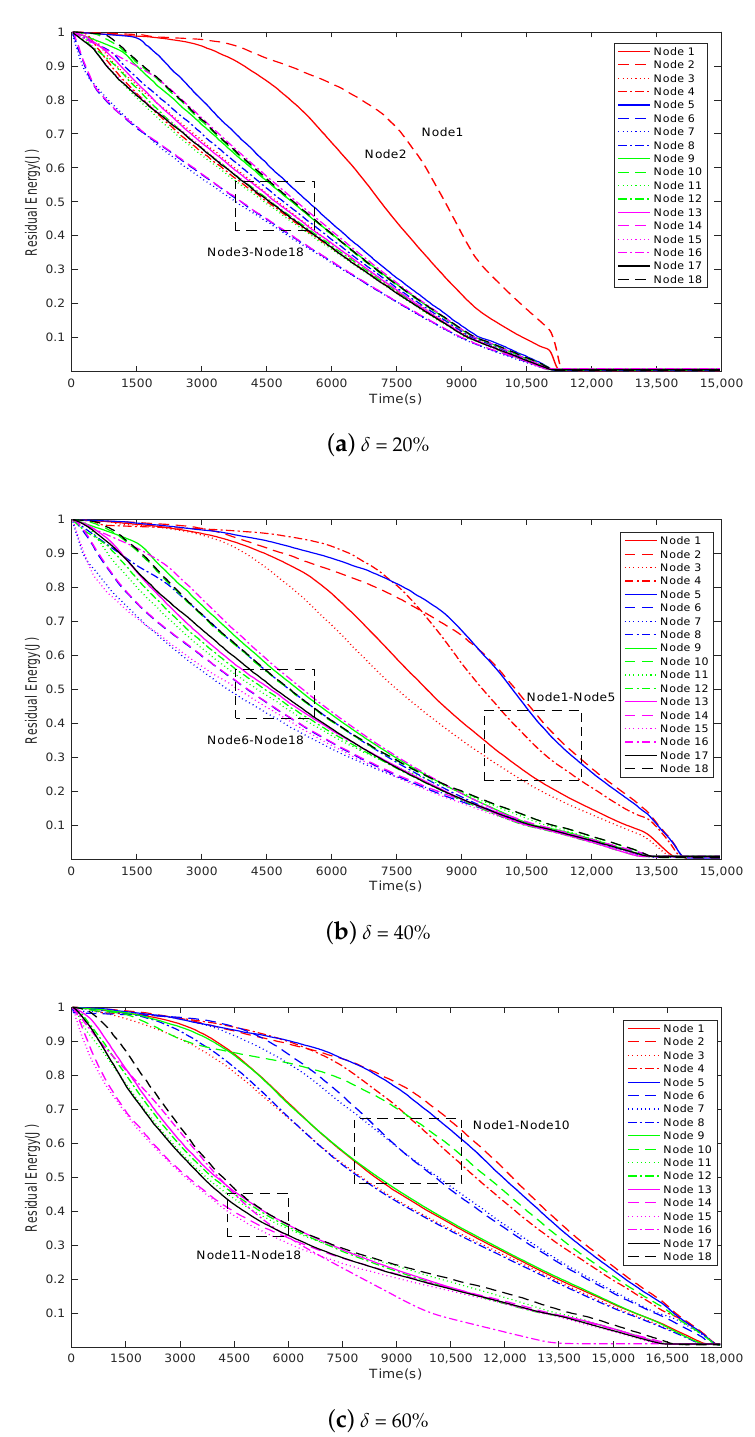
Figure 6. The energy consumption of the 18 nodes near the sink node when the proportion of malicious nodes is 20%, 40%, and